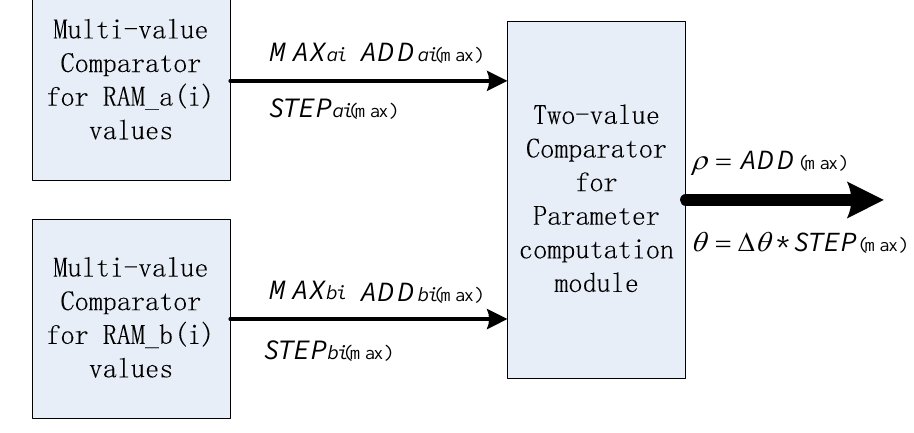
Figure 11. Block diagram of the maximum search scheme for parallel pipeline units.